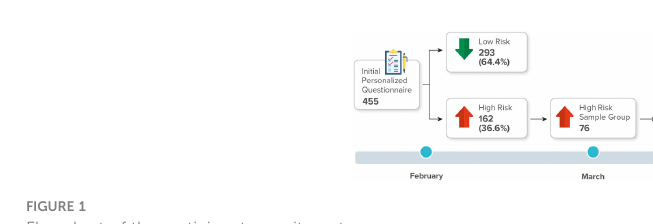
FIGURE 1 Flowchart of the participant recruitment